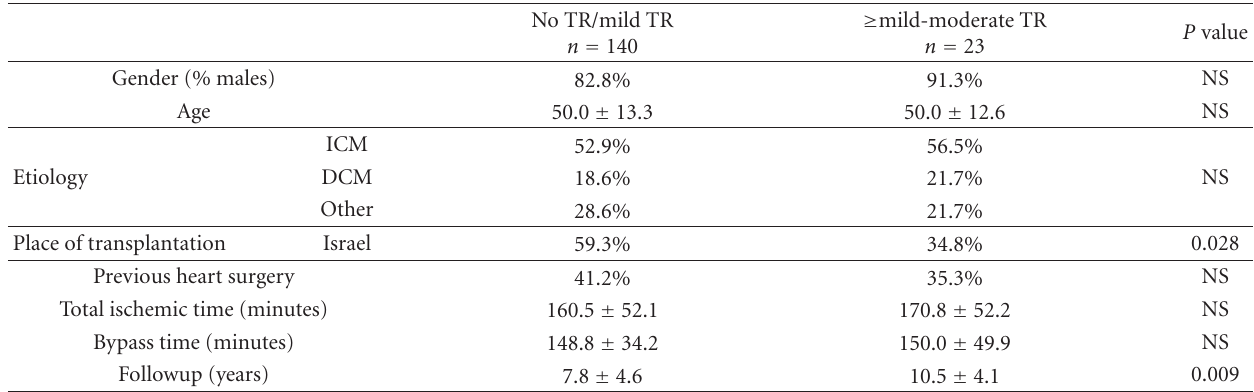
Table 1: Patients demographics and characteristics.